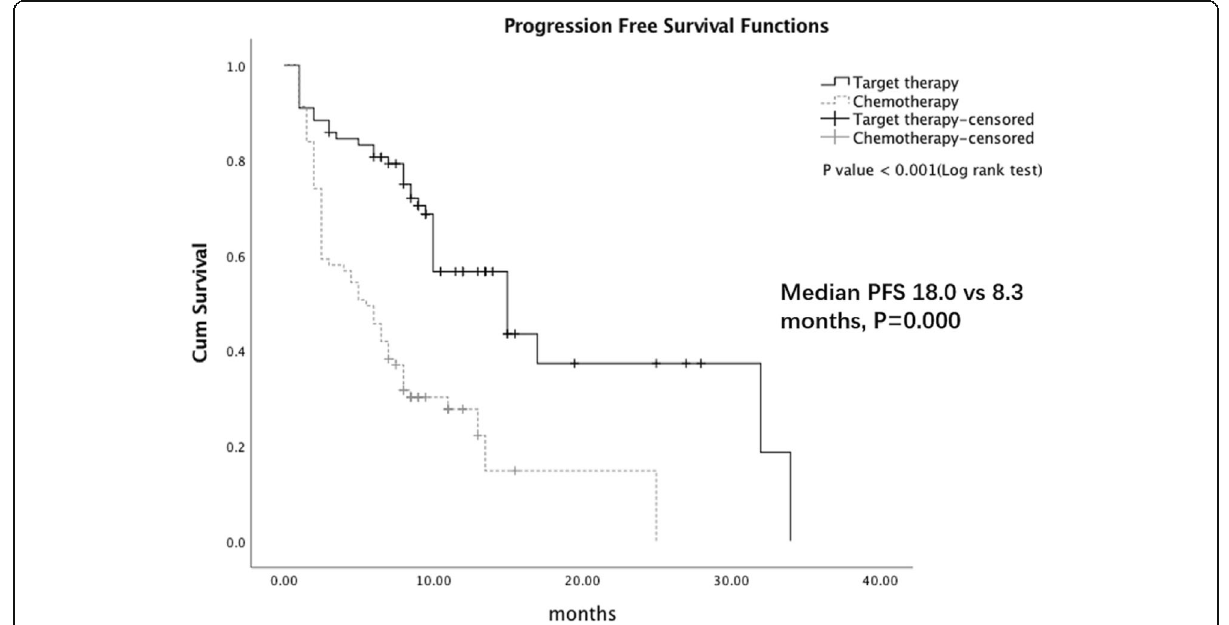
Fig. 2 PFS in EGFR mutation patients compared with EGFR wild-type